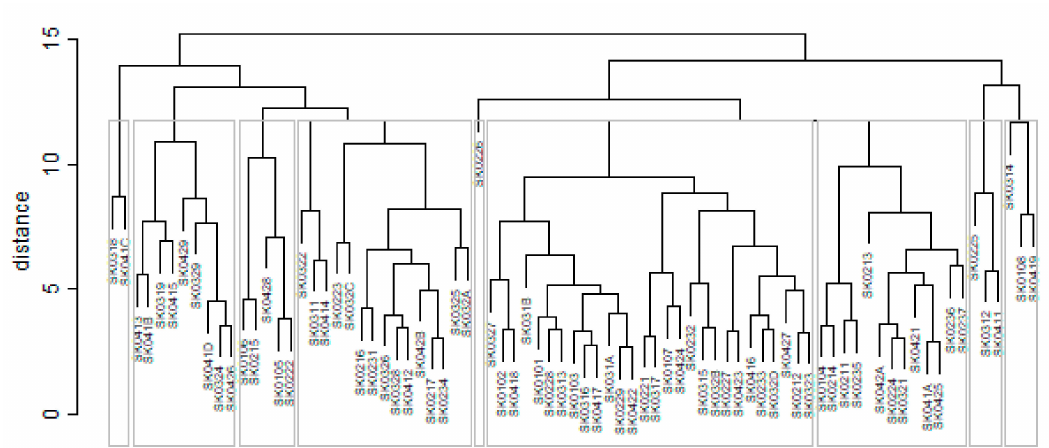
Figure 24. Preventable mortality dendrogram of the districts for the male sex in the year 2015. Source: own elaboration by the authors.